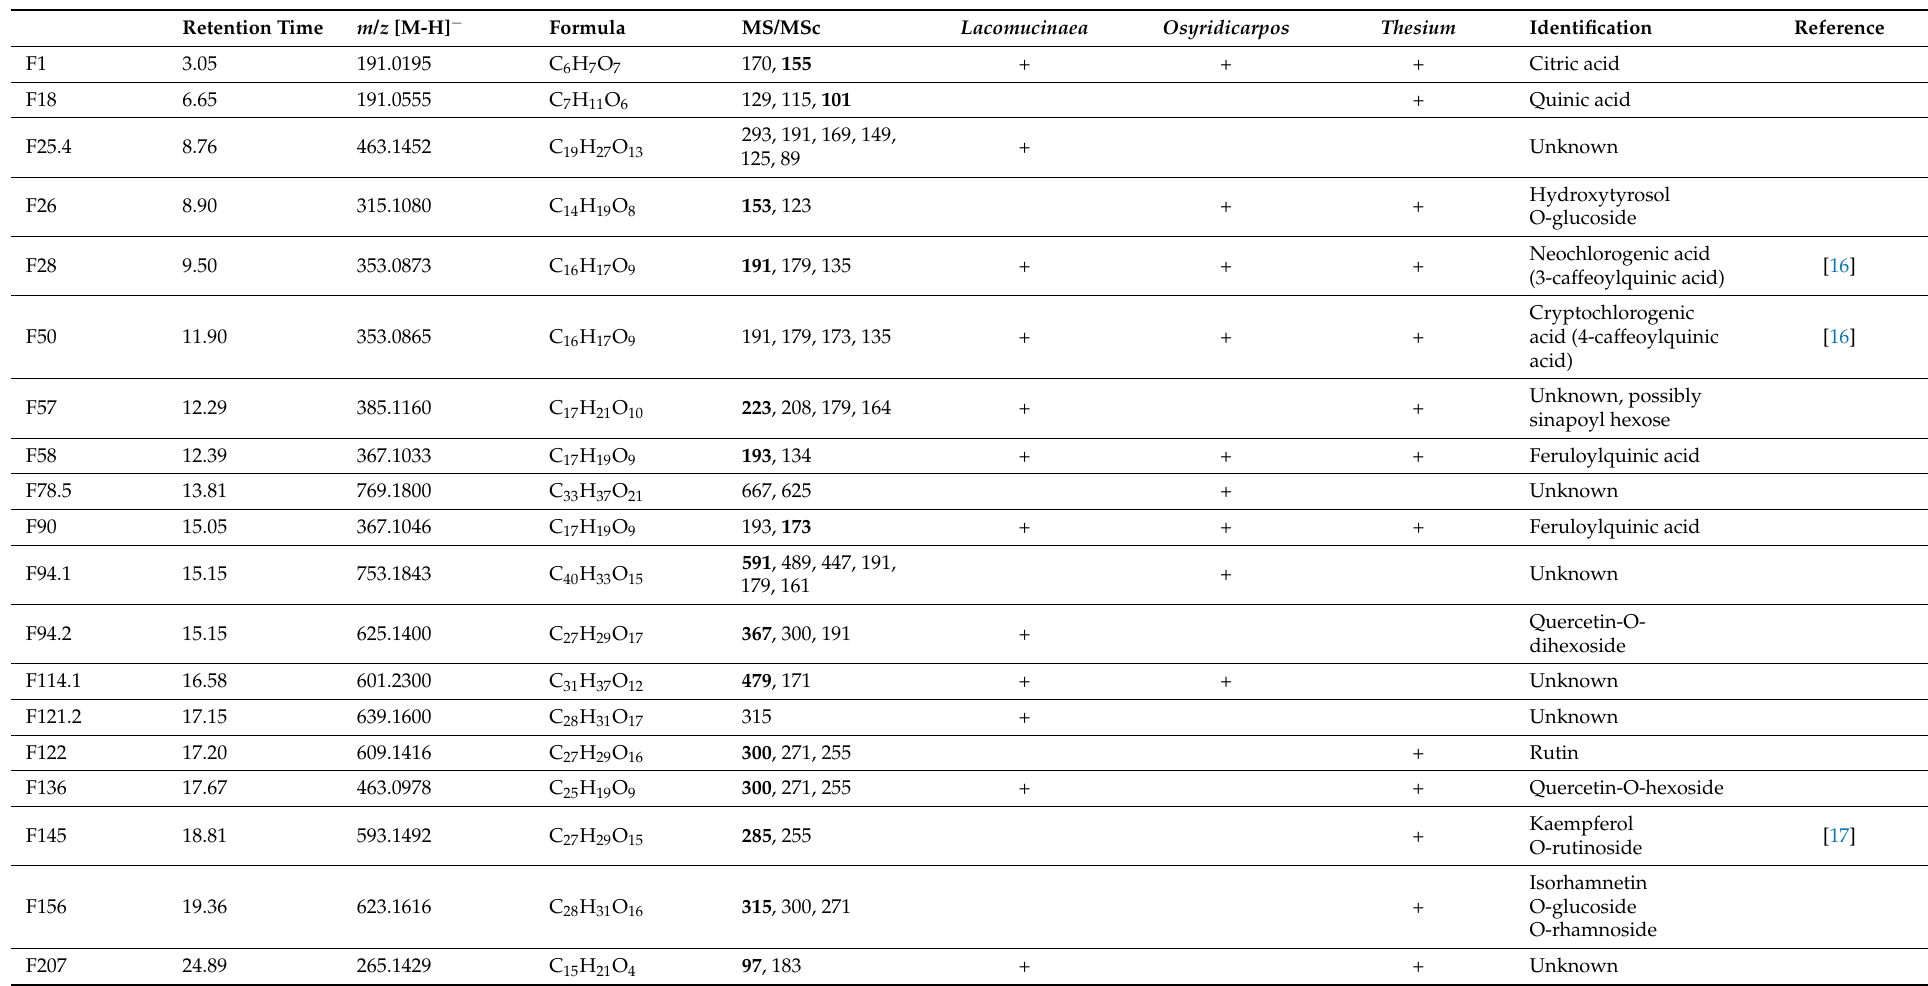
Table 3. Comparison of the main phenolic compounds and organic acids (peak intensity >30%) detected in Lacomucinaea , Osyridicarpos and Thesium